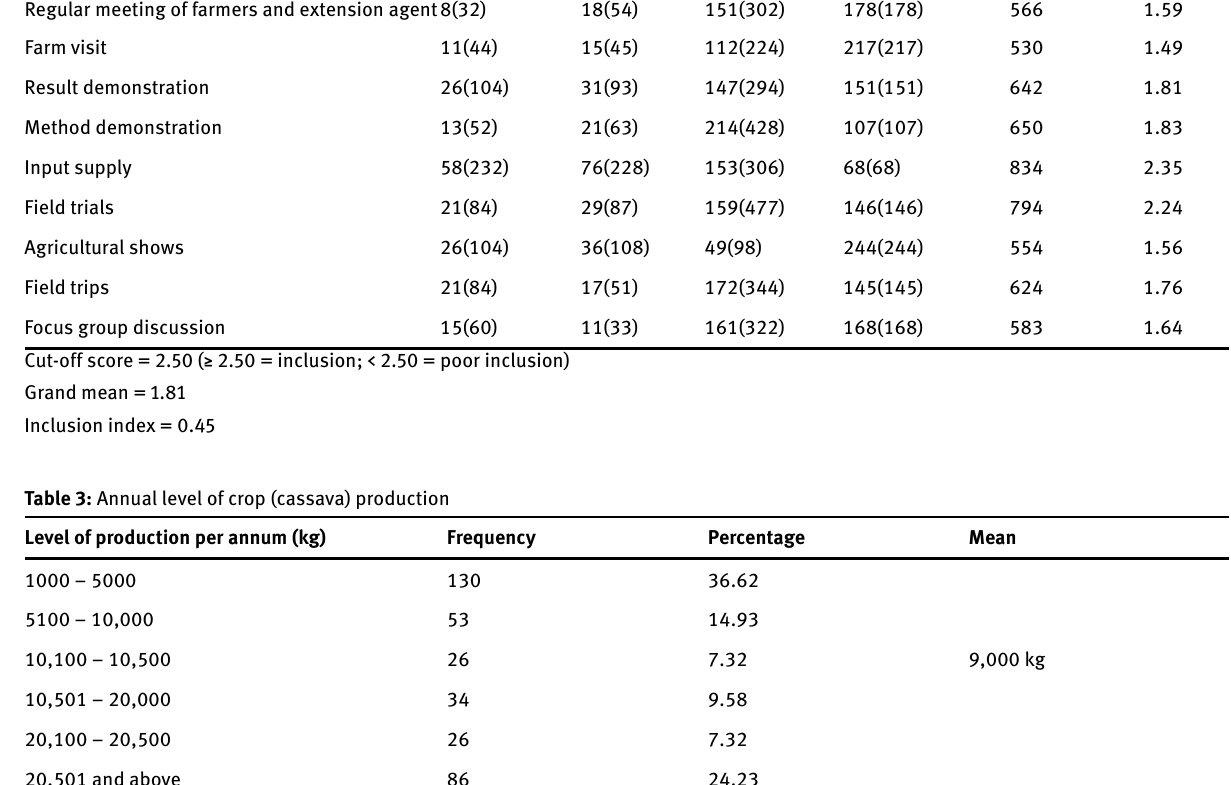
Table 2: Level of inclusion in extension activities Agricultural extension activities